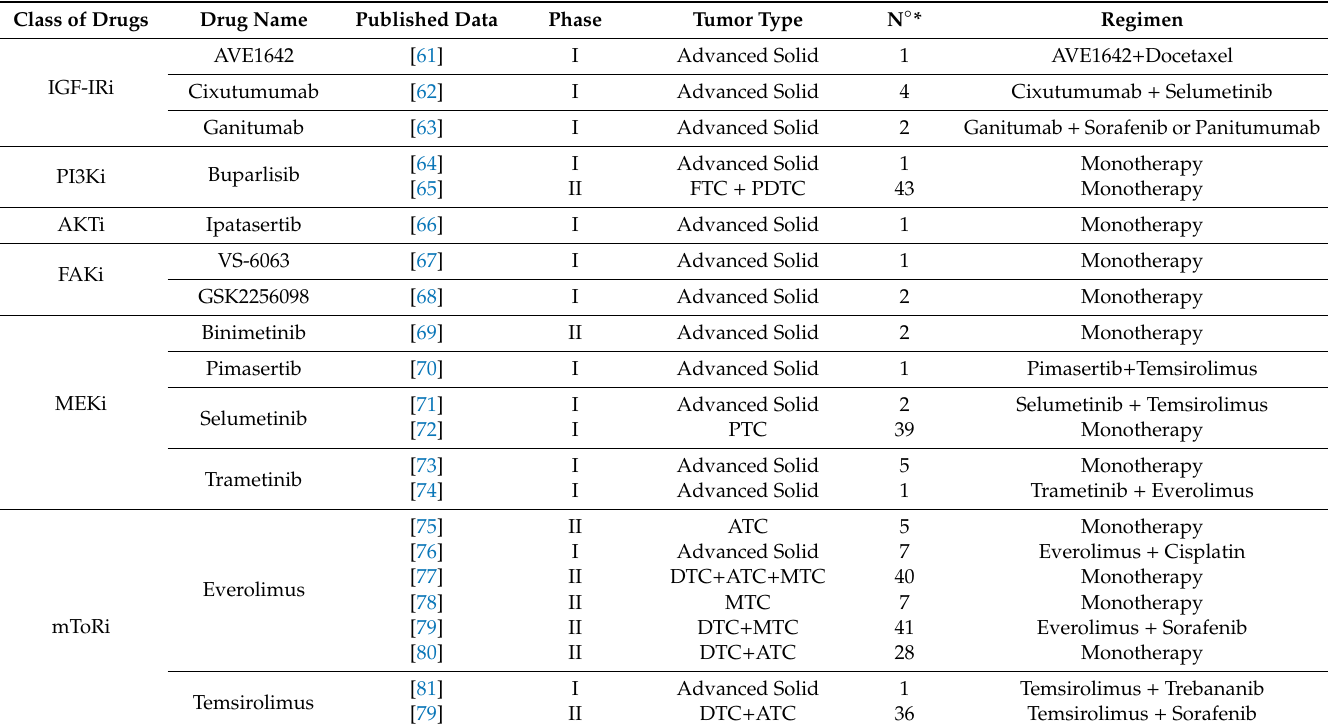
Table 1. Clinical studies with published